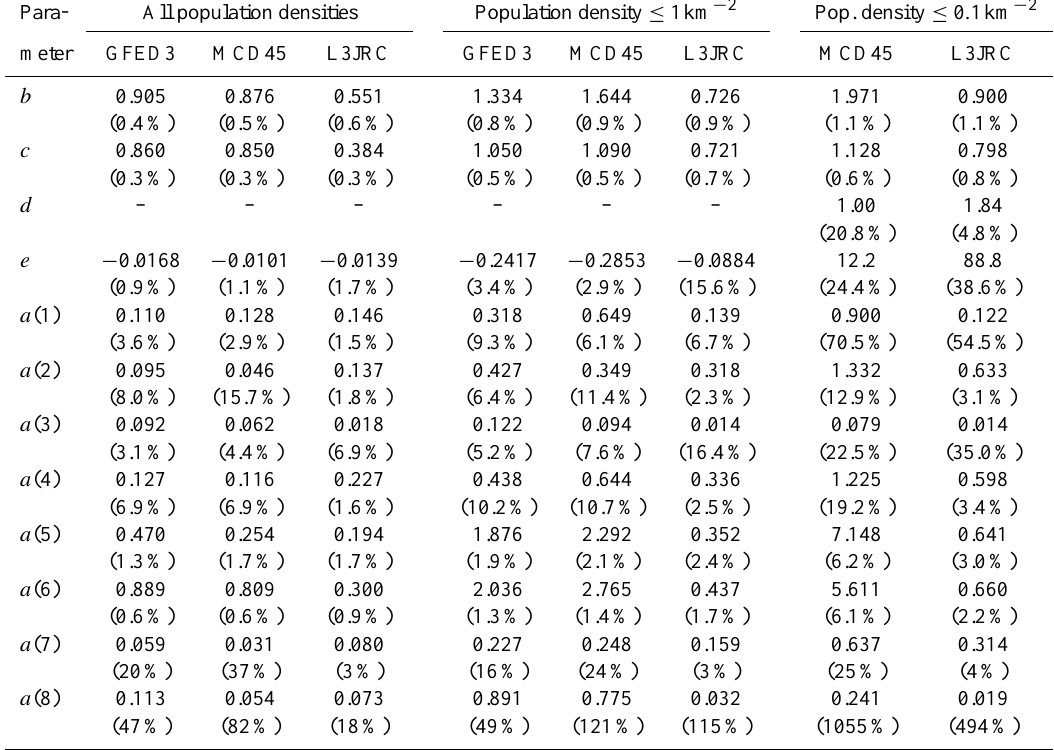
Table 2. Optimal parameters and uncertainties for selected cases with eight regions ∗ . Relative uncertainties given in brackets.